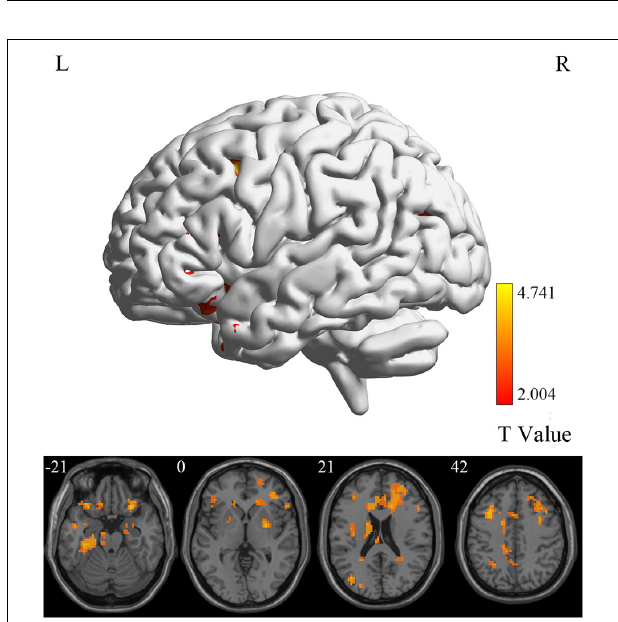
FIGURE 4 | PerAF differences between MCI reverters and HCs. PerAF, percent amplitude of fluctuation; HCs, healthy controls; L, left; MCI, mild cognitive impairment; R, right.